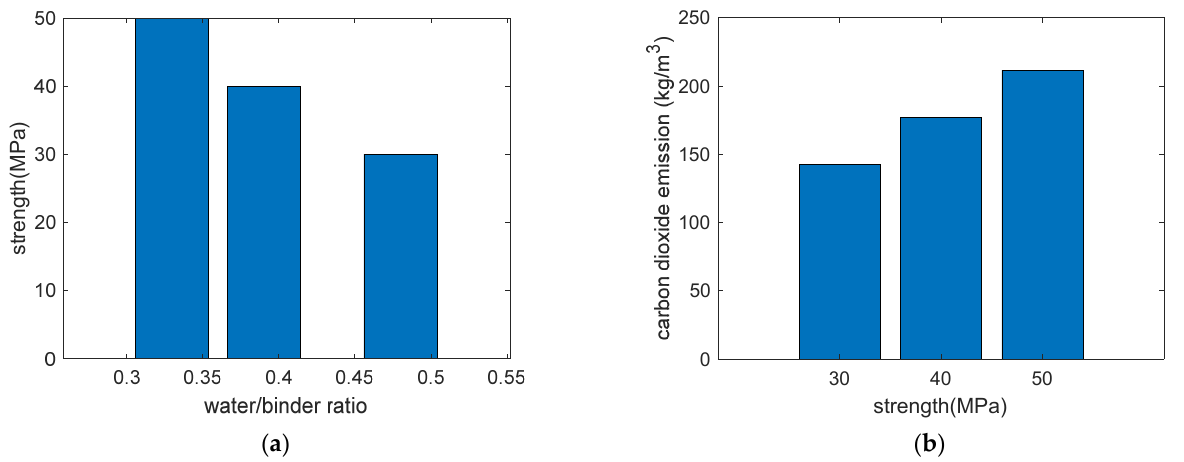
Figure 10. Performance of design example 1 (water content 160 kg/m 3 ). ( a ) Strength versus wa- ter/binder ratio. ( b ) CO 2 emission versus strength.